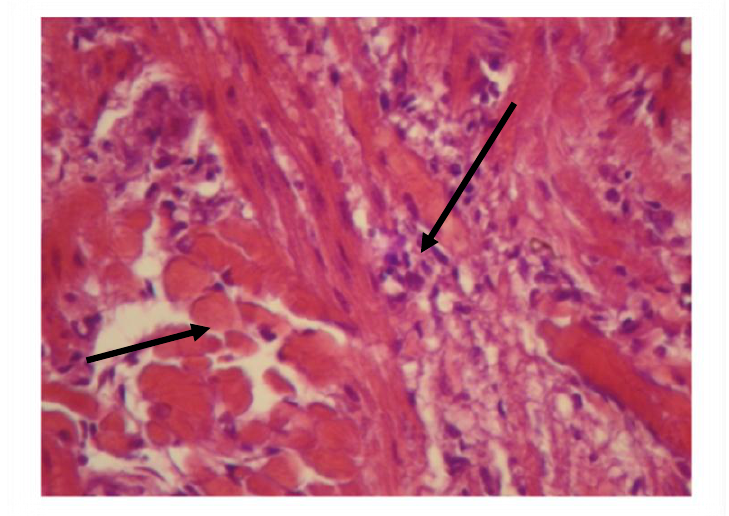
Figure1: Histopathological section of muscle 14day post infection show severe necrosis with haylanized appearance and infiltration PMNCs intra interstitial tissue (H&E40×).